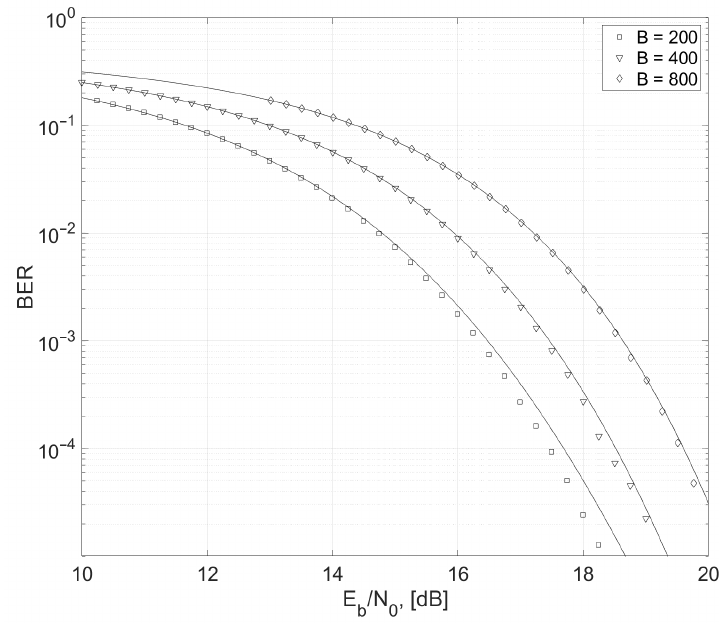
Figure 5. BER as a function of E b / N 0 and processing gain B .